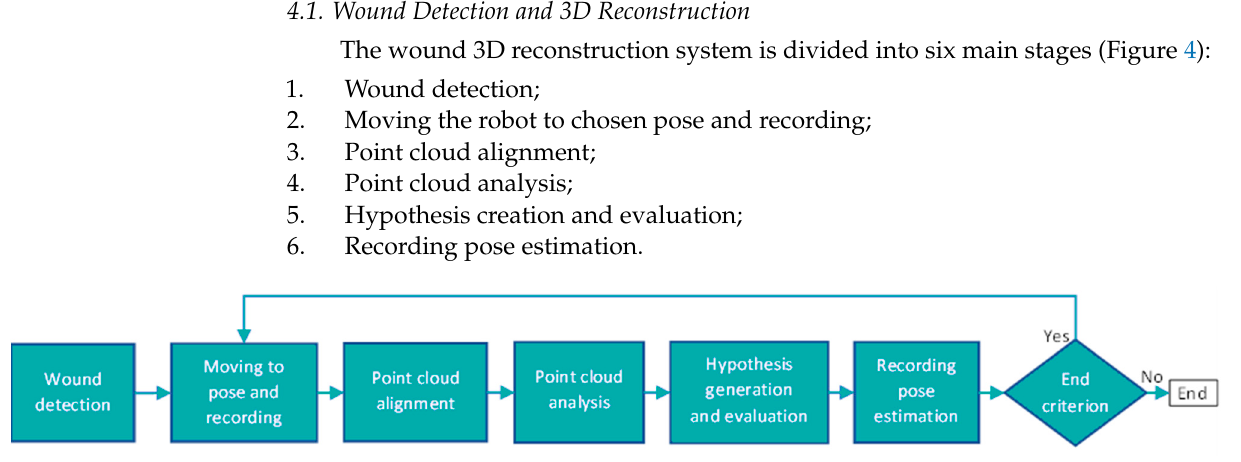
Figure 4. High-level overview of the wound detection and 3D reconstruction